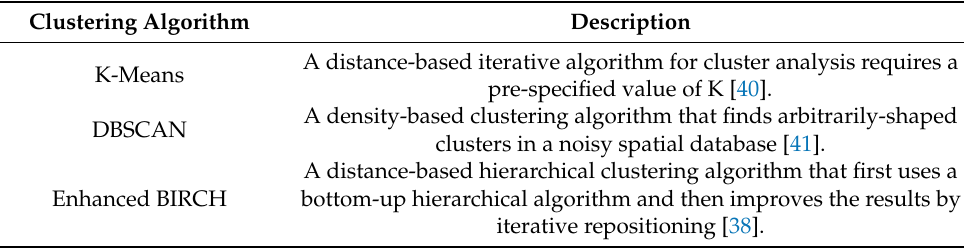
Table 6. Description of the three clustering algorithms.